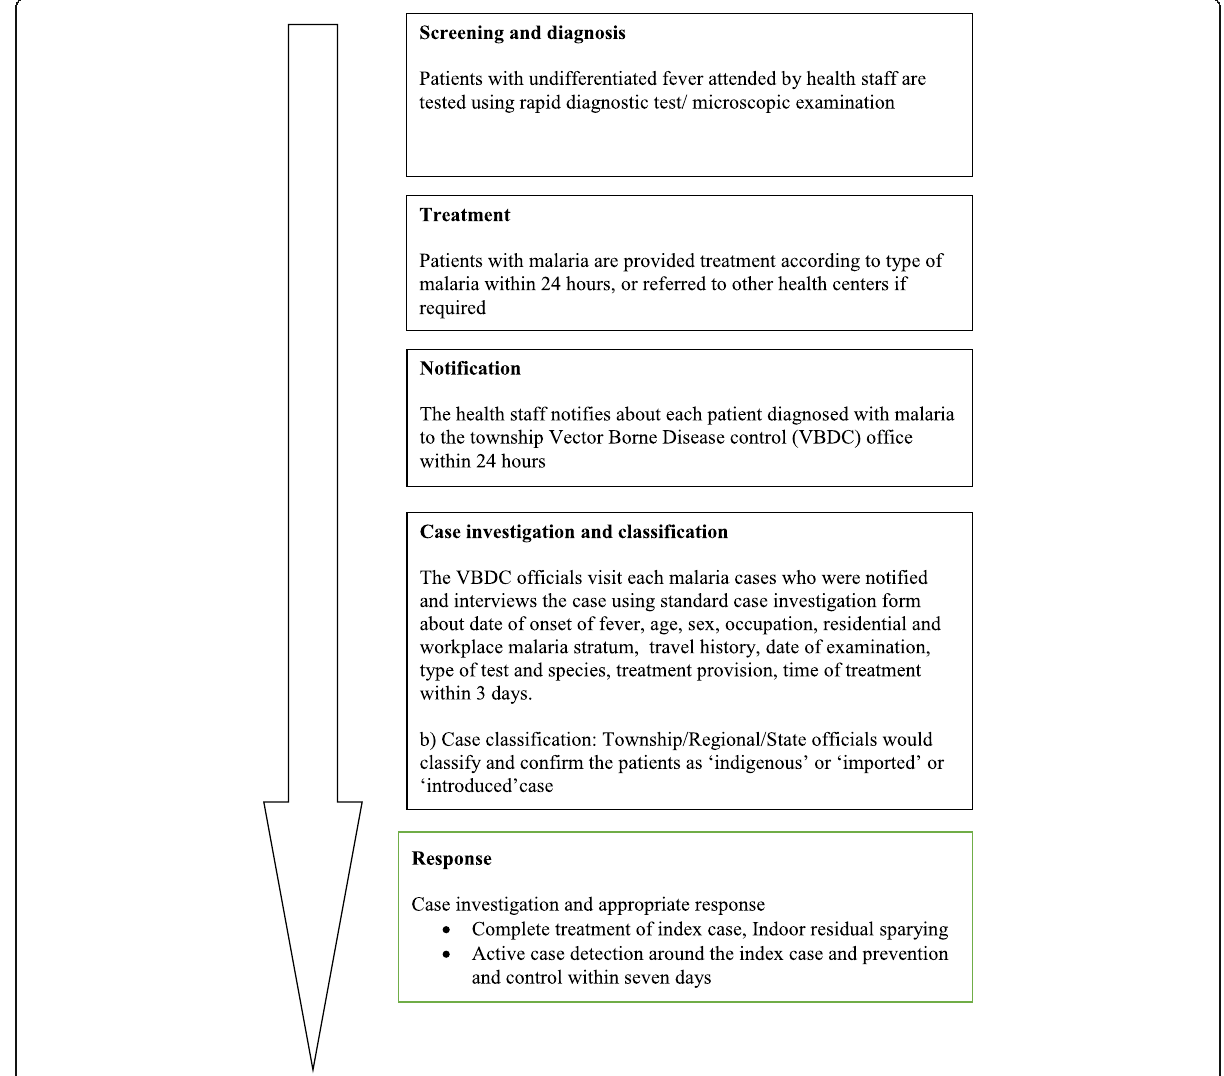
Fig. 2 Case notification, investigation, classification, and response strategy in Yangon, Bago-East, and Mon region/states of Myanmar,